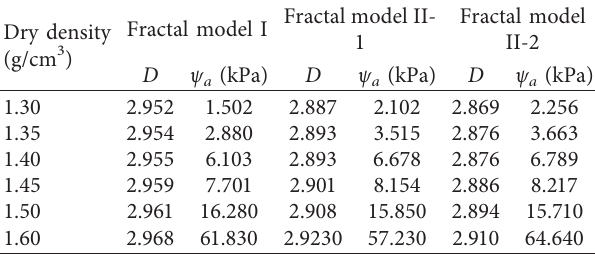
Table 5: The fractal dimension D and the air-entry value ψ termined by model fitting.